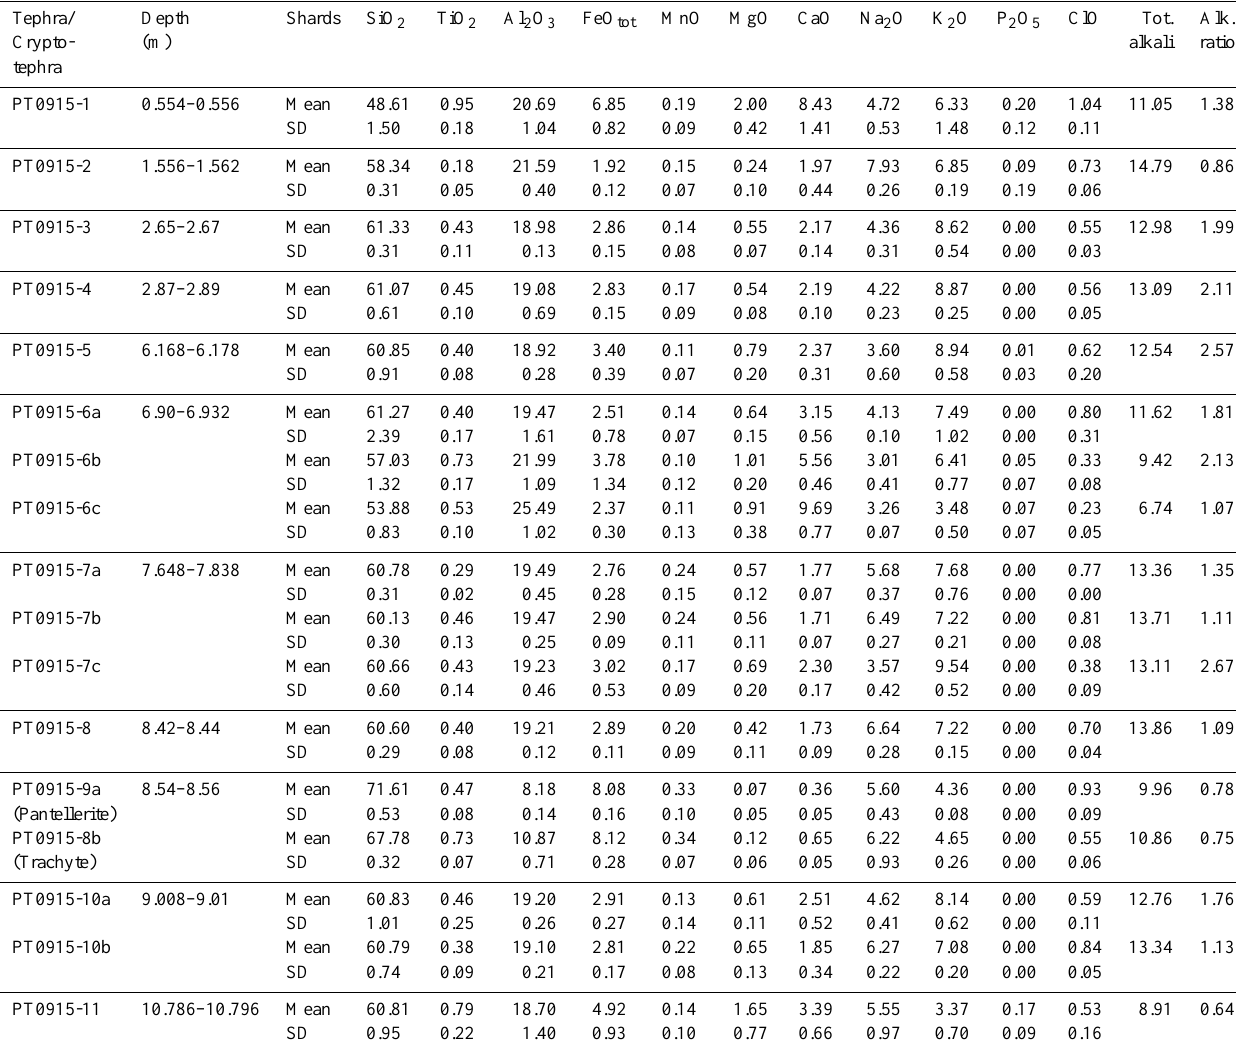
Table 4. Average major element glass composition (normalised to 100%) of investigated tephras and cryptotephras from Lake Prespa core Co1215. The full dataset is given in Table S1 in the Supplement.